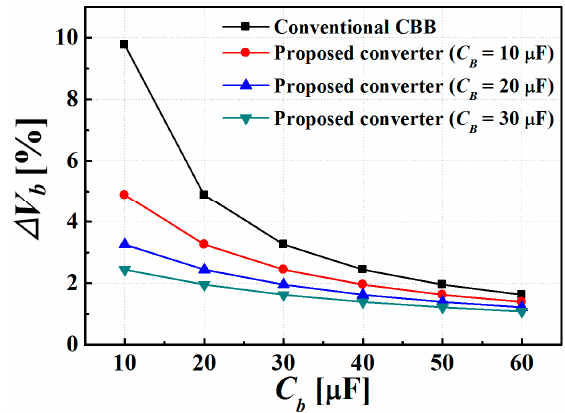
Figure 10. Δ V b vs. C b calculated using a circuit simulator at V a = 48 V, V b = 60 V, and P b = 500 W.